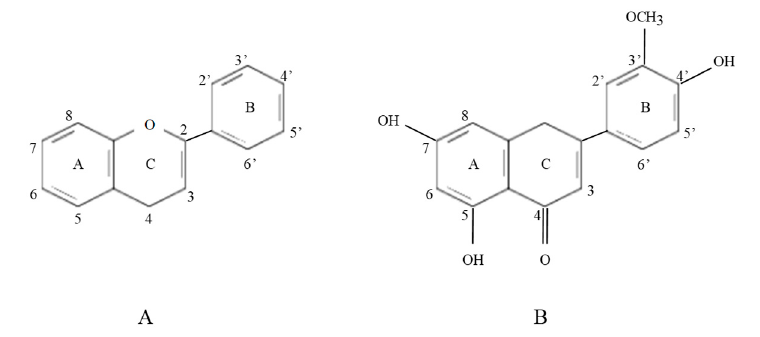
Figure 2. ( A ): Basic skeleton of flavonoids, ( B ): Isorhamnetin.